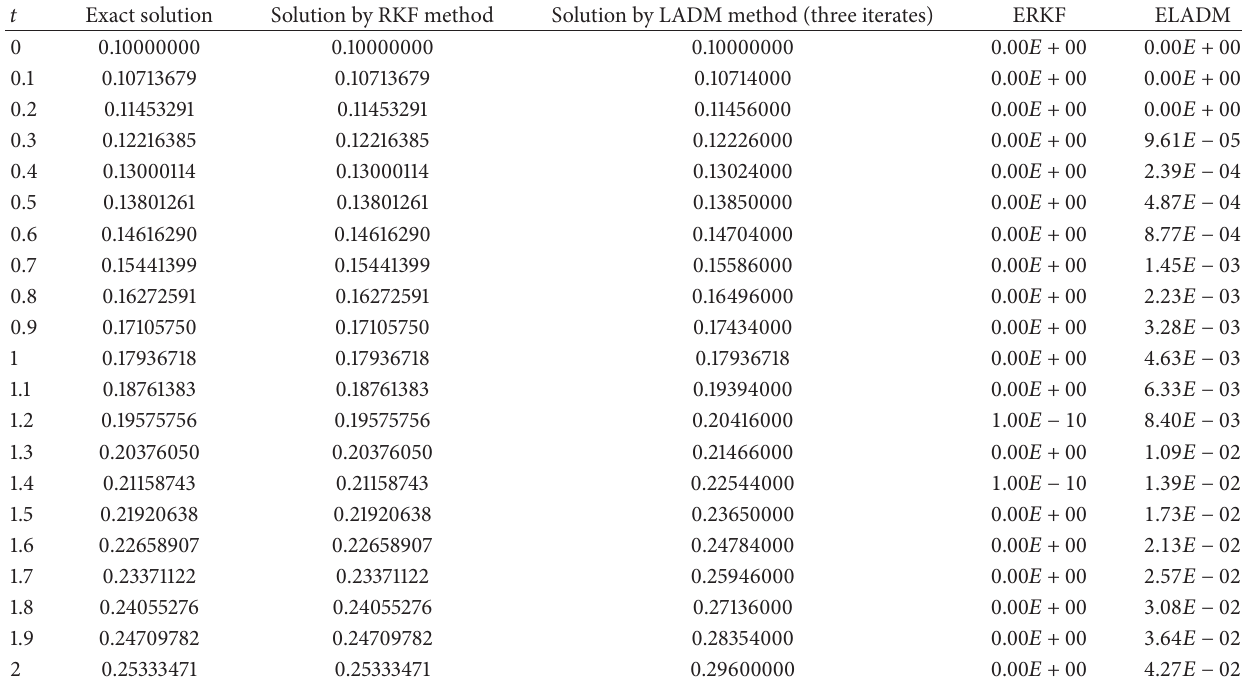
Table 4: Numerical comparison when 𝑁(0) = 0.1 , 𝑎 = 3 , 𝑏 = 1 , ℎ = 0.1 .